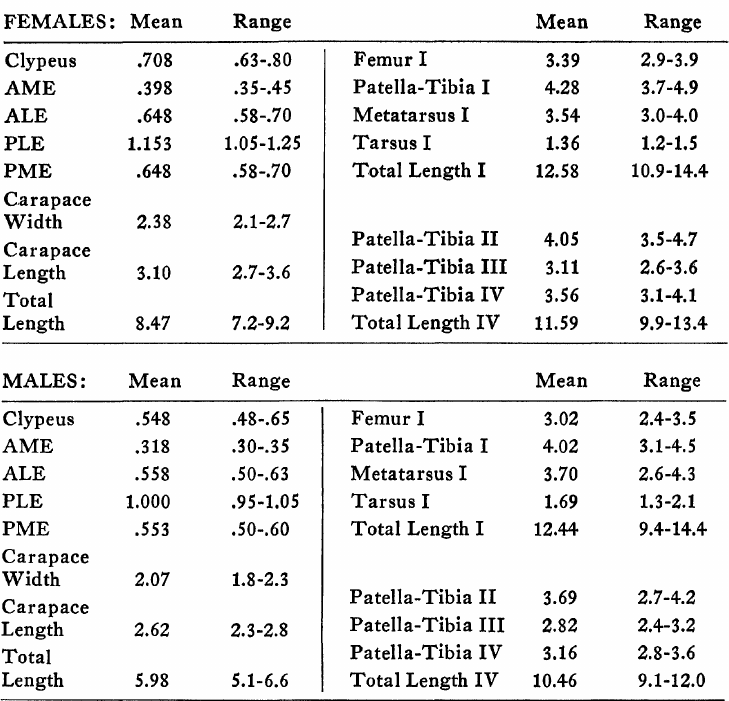
240 Psyche [June Measurements. Ten emales and ten males.